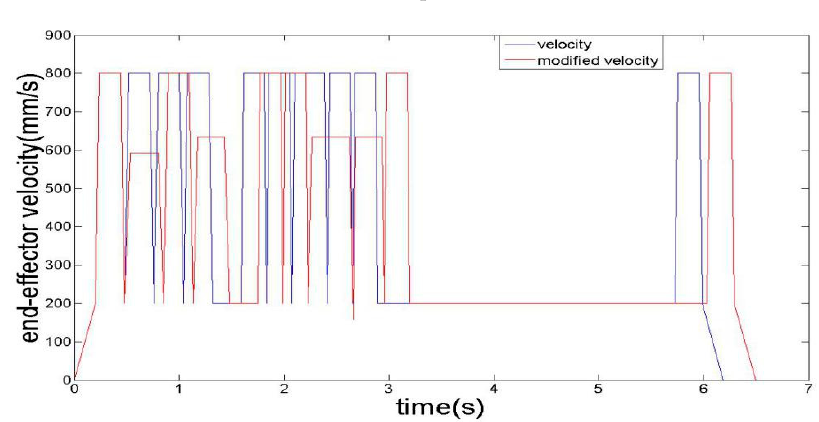
Figure 1. The Cartesian path of the Efort robot.